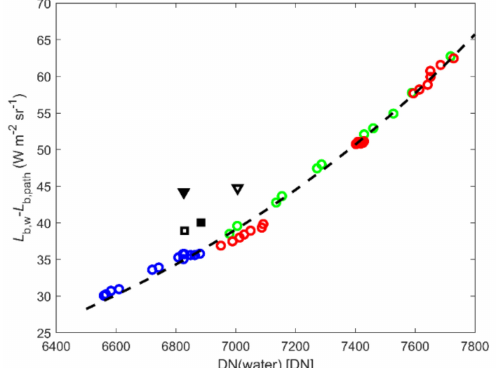
Figure 3. Scatter plot of the modeled L b,w − L b,path (Equations (1)–(3)) as a function of DN, using data from Figure 2. The dashed line indicates Equation